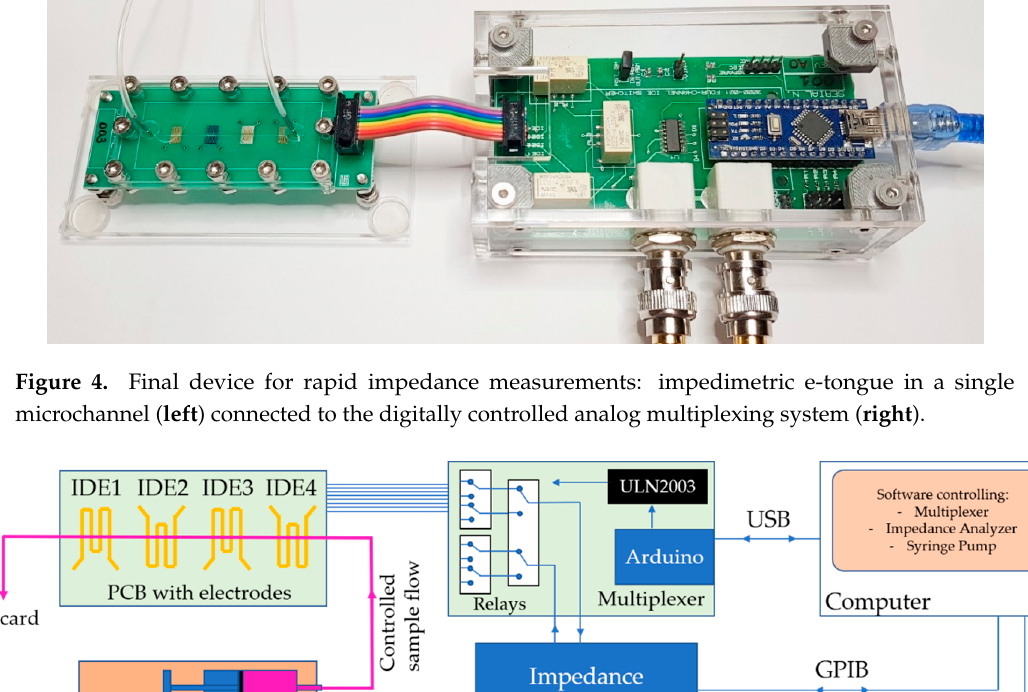
Figure 5. Diagram of the e-tongue setup comprising the microfluidic e-tongue device, syringe pump,